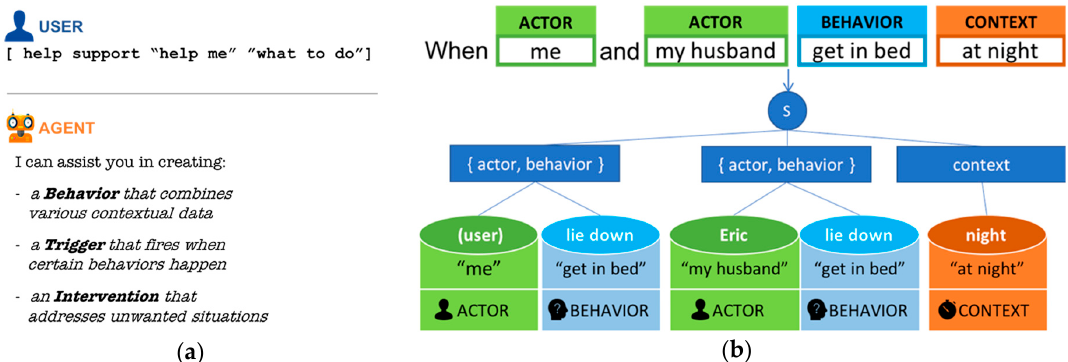
Figure 4. ParlAmI supports a variety of topics that correspond to the different rule types that can be created. Contrary to a sequential user interface (UI), conversations about different topics can be interwoven without affecting the overall functionality.